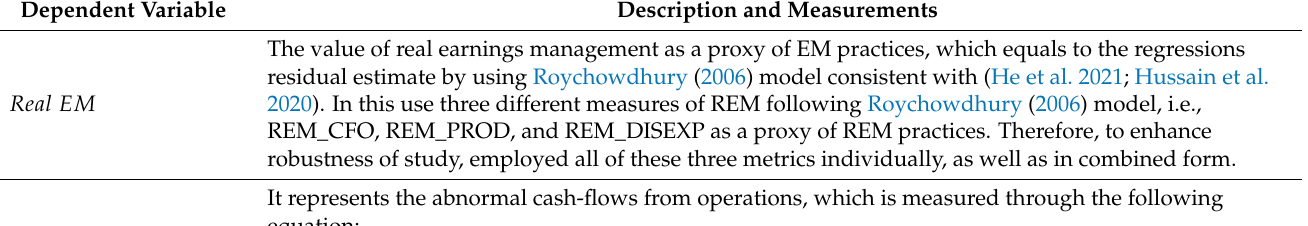
Table 1. Variables description and